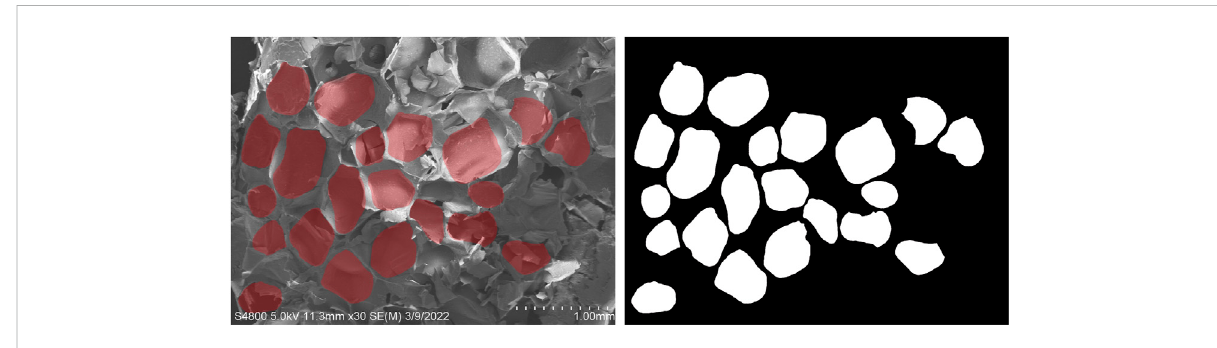
FIGURE 3 Image processing and an example of a fi eld of vision in group B.